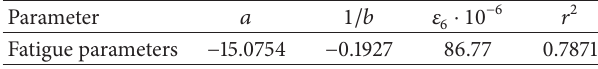
Table 3: Values of fatigue parameters for mix AC 11 O.